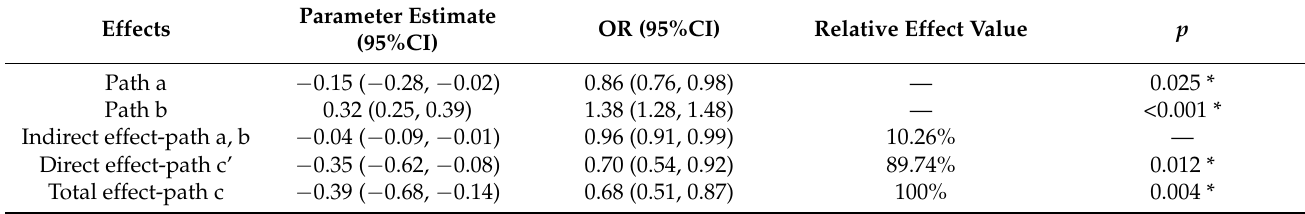
Table 3. Mediation analysis of the relationship between 25(OH)D 3 levels and T2DM by TG.